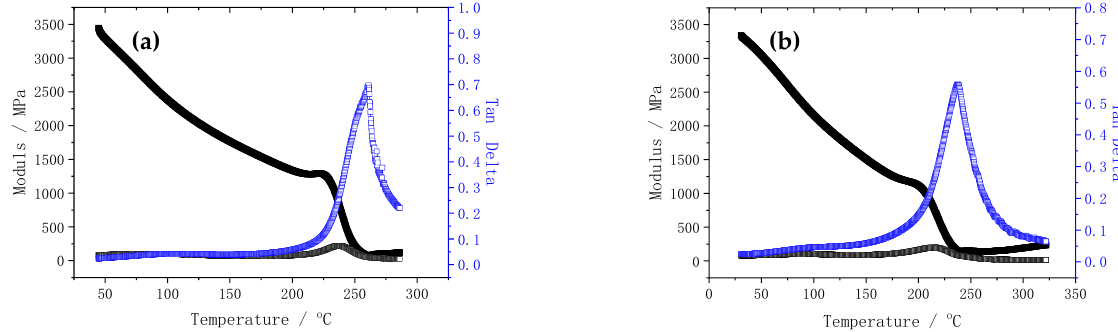
Figure 5. Dynamic thermomechanical analysis (DMTA) of BMI ( a ) and BMI–BT5501A ( b ).